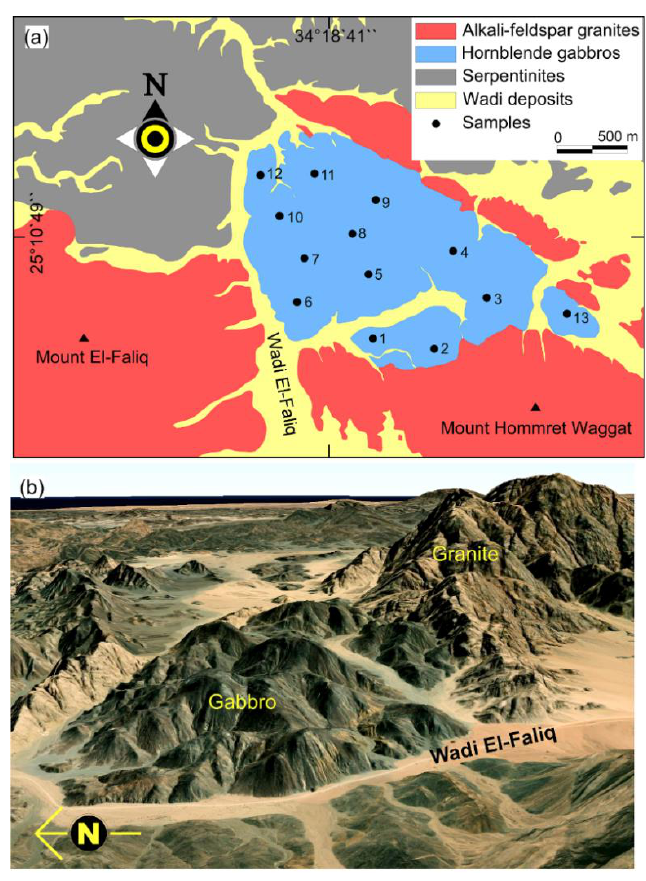
Figure 2. ( a ) A simplified geological map of the Wadi El-Faliq in the central Eastern Desert of Egypt showing the different lithologies in the area; and ( b ) a satellite image (ArcGIS Earth) of the northern side of the Wadi El-Faliq showing the relationship between gabbroic rocks and granites.